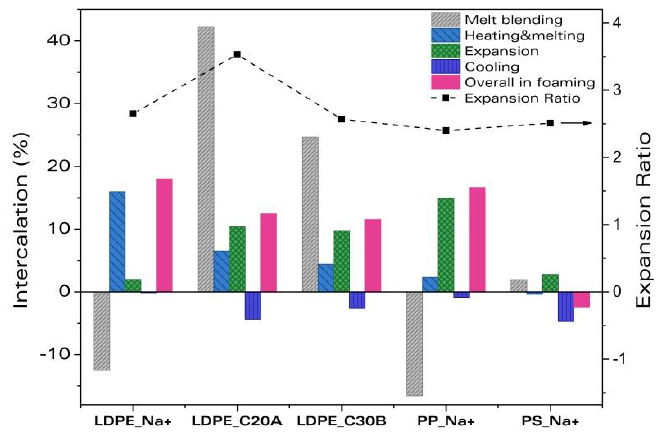
Figure 6. Summary of all the intercalation degrees measured in this work for the different systems and final expansion ratios of the foams.